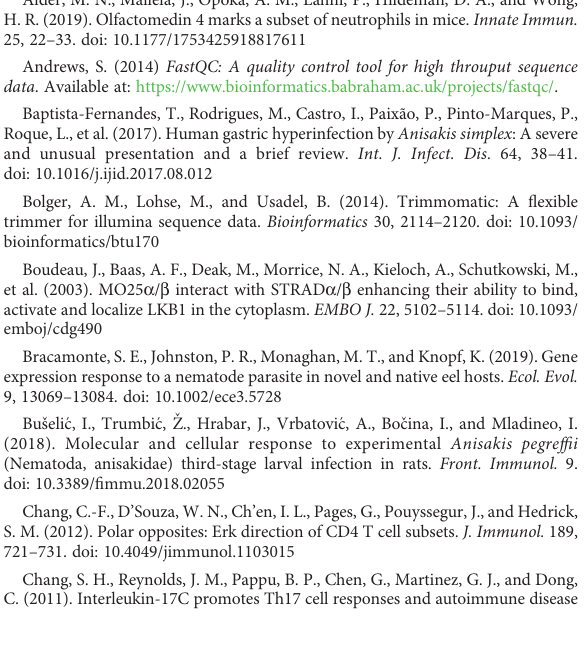
SUPPLEMENTARY TABLE 3 List of enriched pfam of upregulated genes in the peripheral blood leukocytes (PBLs) of rat ( R. norvegicus ) stimulated by A. pegref fi i crude extract 1 and 12 h post-stimulation. SUPPLEMENTARY TABLE 4 List of ribosome- and nucleolar stress-enriched transcripts in the rat ( R. norvegicus ) peripheral blood leukocytes (PBLs) stimulated by A. pegref fi i crude extract 1 and 12 h post-stimulation. Note that only 60S ribosomal protein L13 (RPL13, 12 h post stimuli, 4.99 logFC) and inositol- pentakisphosphate 2-kinase (IPPK, 12 h post stimuli, 4.32 logFC) have been differentially expressed between 1 and 12 h